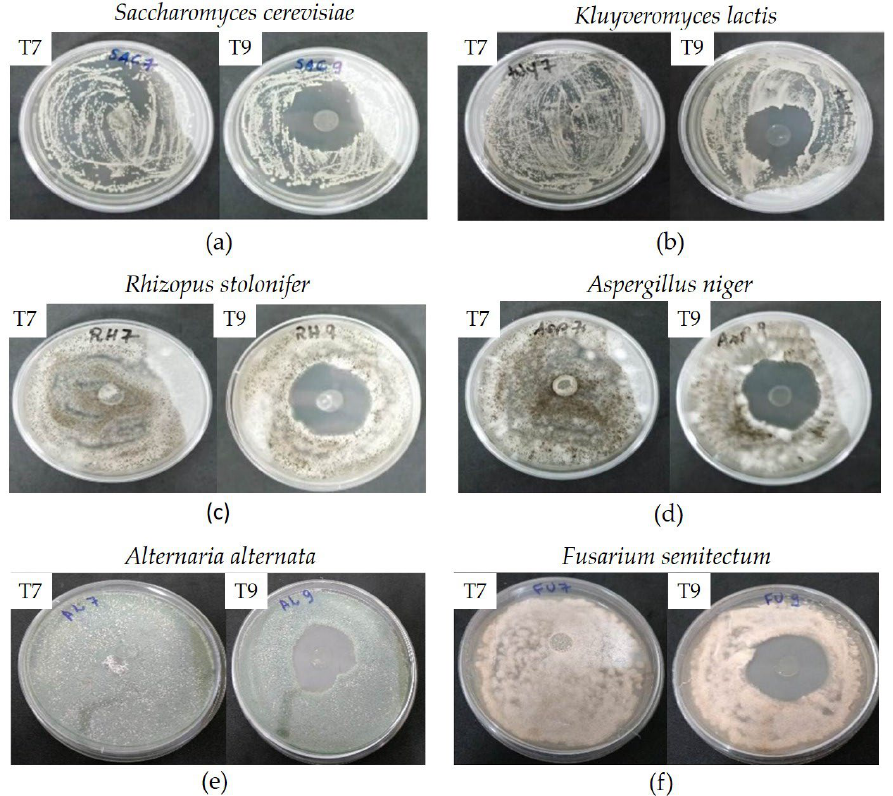
Figure 4. Photographs of plates after incubation of different yeasts ( S. cerevisiae ( a ) and K. lactis ( b )) and molds ( R. stolonifer ( c ), A. niger ( d ), A. alternate ( e ), and F. semitectum ( f )) at 25 °C for 7 days. T7: films with 2.5% of CNC and 0% of natamycin. T9: films with 2.5% of CNC and 2.5% of natamycin.